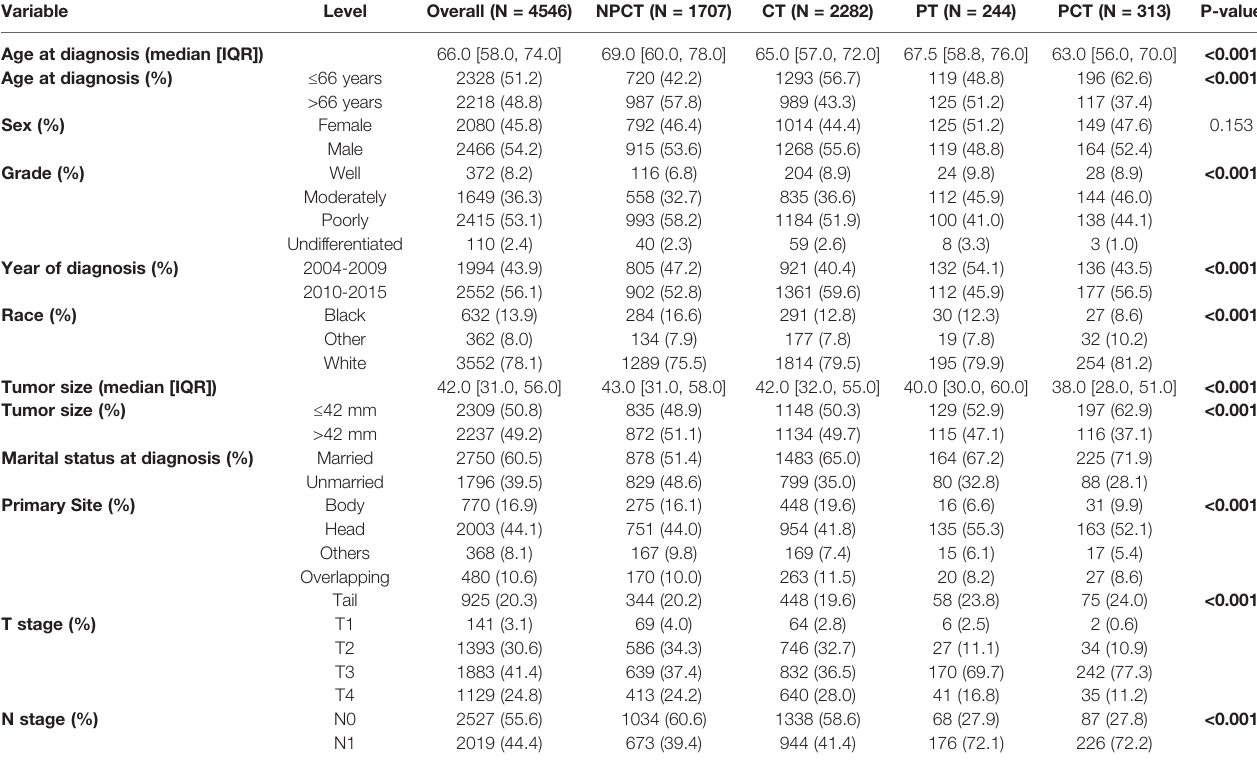
TABLE 1 | Clinicopathological Characteristics of mPC patients with PCT, PT, CT or with no treatment. Variable